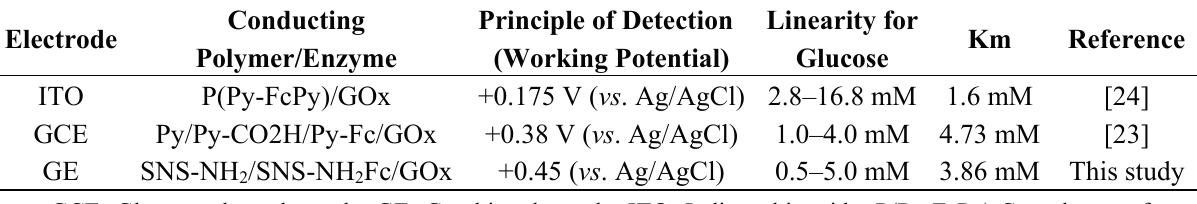
GCE: Glassy carbon electrode; GE: Graphite electrode; ITO: Indium thinoxide; P(Py-FcPy):Co-polymer of pyrrole and ferrocenecarboxylate modi fi ed pyrrole; Py/Py-CO 2 H/Py-Fc: Pyrrole/N-(3-(1H-pyrrol-1-yl)ethyl) ferrocenecarboxate; ferrocene